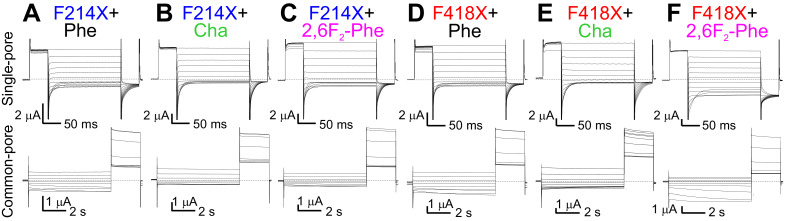
Effects of charge redistribution at Pheex and Phecen on the single- and common-pore gating processes of CLC-0.(A–F) Representative TEVC currents evoked with single- (top) and common-pore (bottom) gating protocols of the following CLC-0 variants: Pheex (F214X) replacements with Phe (A), Cha (B) or 2,6F2-Phe (C); Phecen (F418X) substitutions with Phe (D), Cha (E) or 2,6F2-Phe (F).